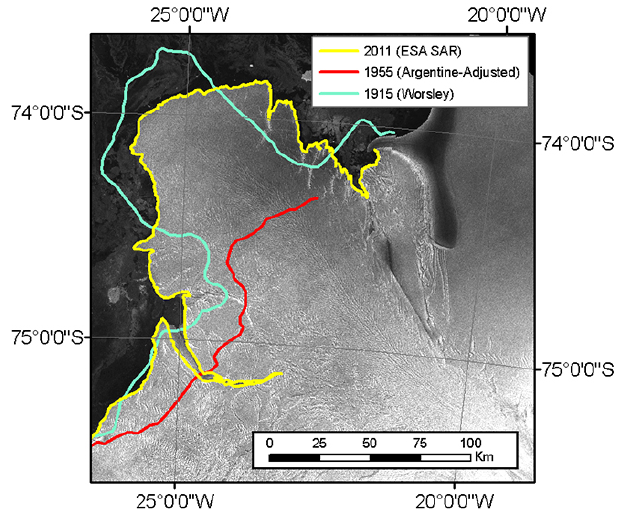
Fig. 7. Historical ice-front recordings of the SWGT. The less reli- able 1955 ice front is shown here as the 1958 survey did not include SWGT.